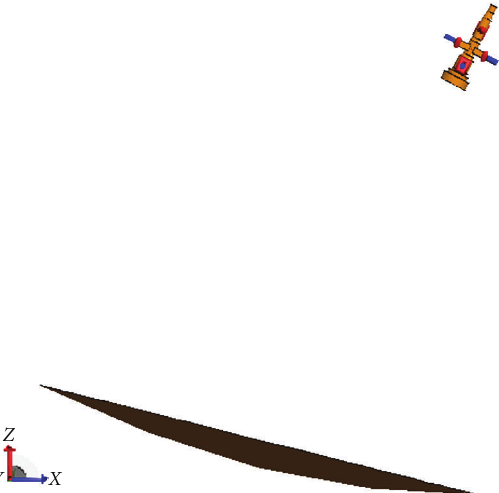
Figure 12: Configuration of the o ff set reflector antenna fed by a triple-mode feedhorn.